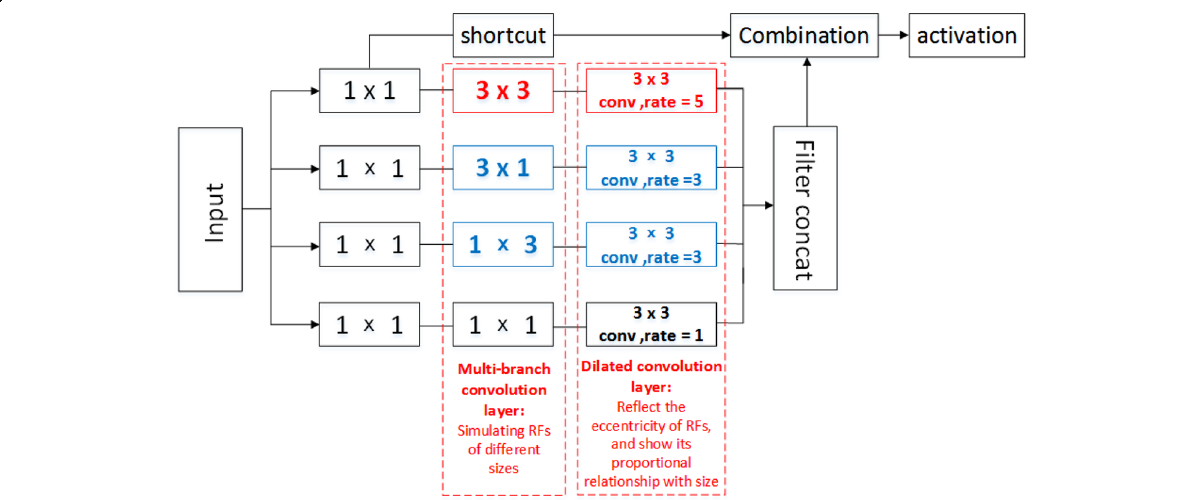
Fig. 6 The structure diagram of RFB-s module. Similar to Fig. 3b and Fig. 3c, two cascaded 3 × 3 convolutions are used to replace the 5 × 5 convolution in Fig. 5, and 1 × 3 convolutions and 3 × 1 convolution cascades are used to replace the 3 × 3 convolution layer in Fig. 5. The computational complexity is reduced while the smaller RFs in the shallow retinal map are